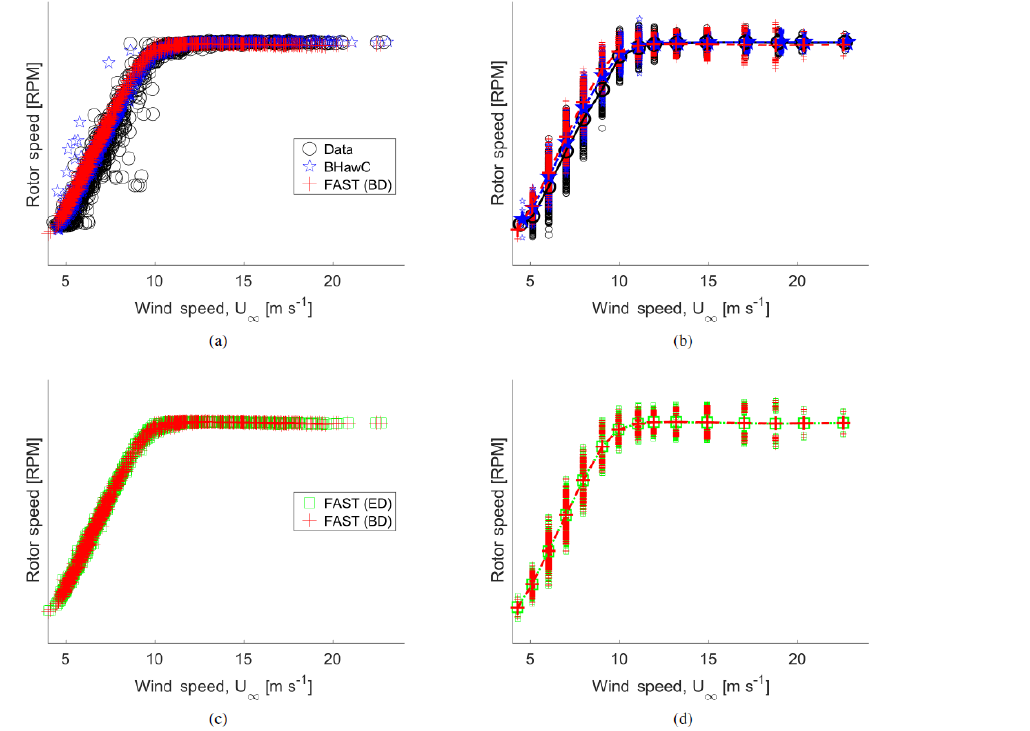
Figure 2. Rotor speed. (a) Individual 10min averages from experimental data, BHawC, and FAST (BD). (b) Binned averages of data in (a) are denoted by points connected by lines; the scatter above and below these data denotes plus or minus 1 standard deviation, respectively, of the individual 10min data sets in that bin. (c) Individual 10min averages from FAST (BD) and FAST (ED). (d) Binned averages of data in (c) are denoted by the points connected by lines; the scatter above and below these data denotes plus or minus 1 standard deviation, respectively, of the individual 10min data sets in that